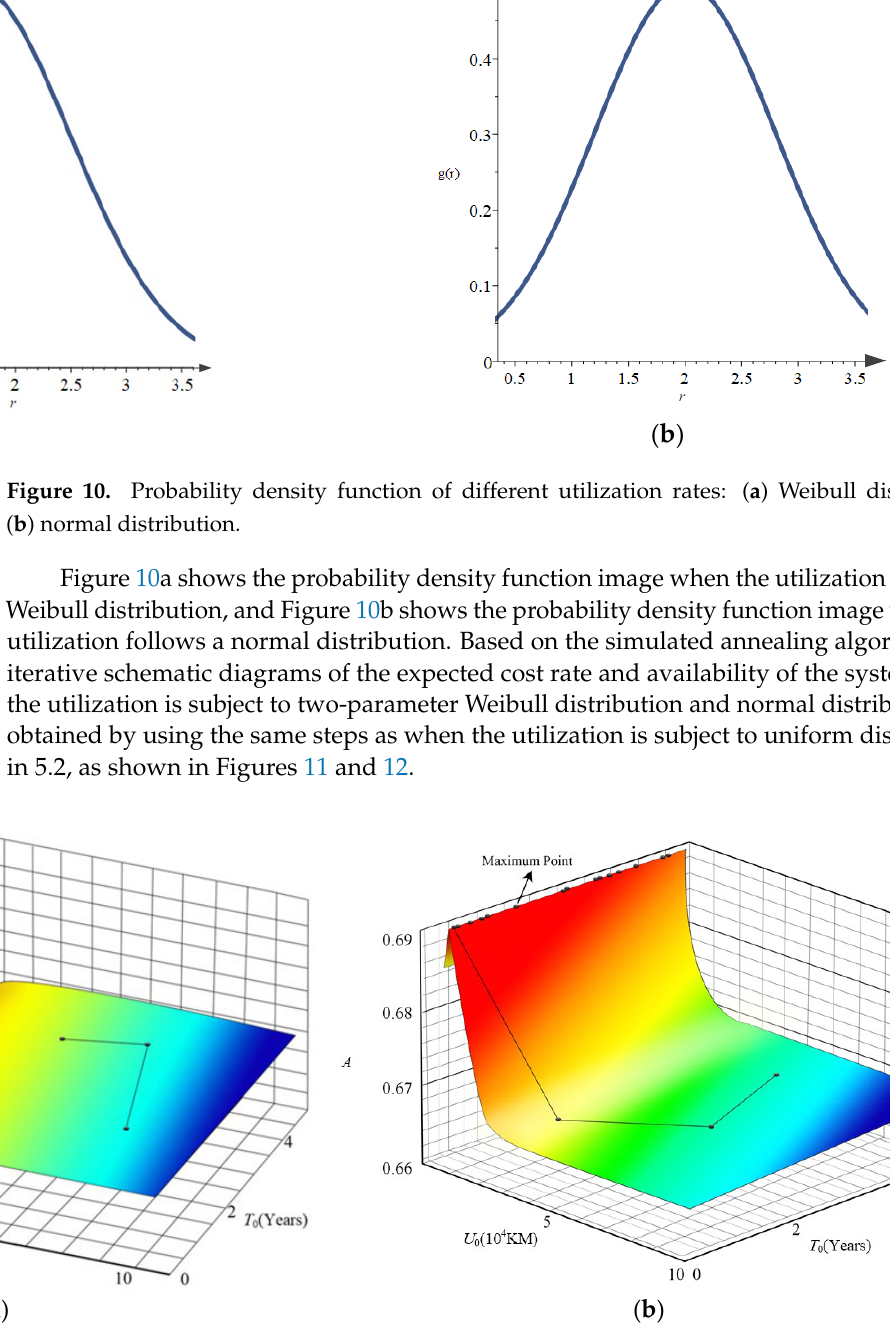
Figure 11. Iteration when utilization rate follows Weibull distribution. ( a ) Minimum warranty cost under Weibull distribution, ( b ) The highest availability under Weibull distribution.